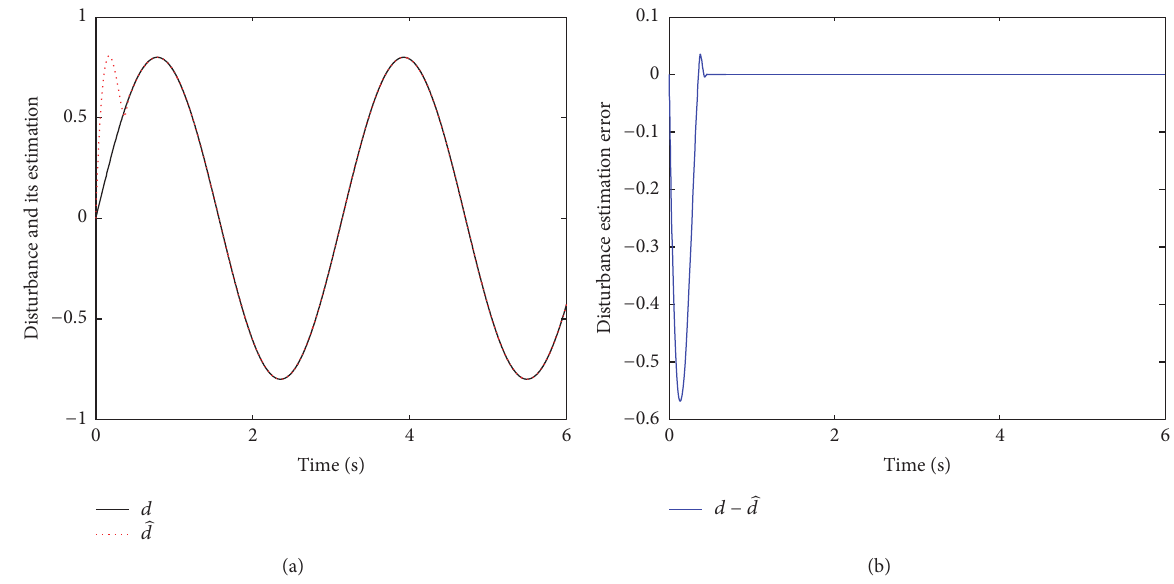
Figure 2: Response curves of disturbance and its estimation (a) and estimation error (b).